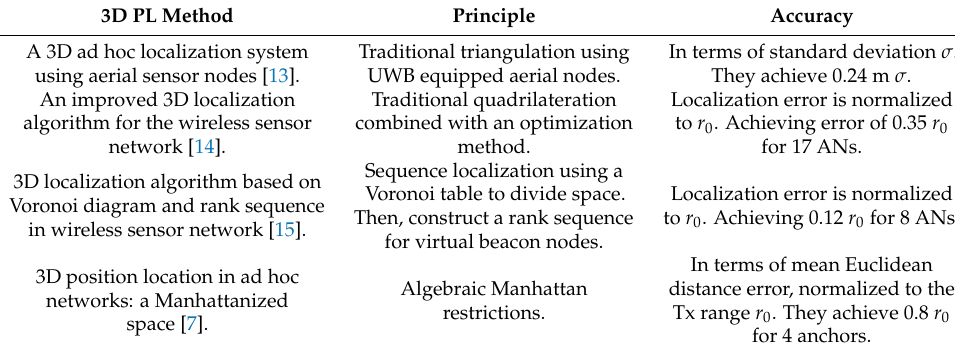
Table 1. Summary of outdoor 3D PL